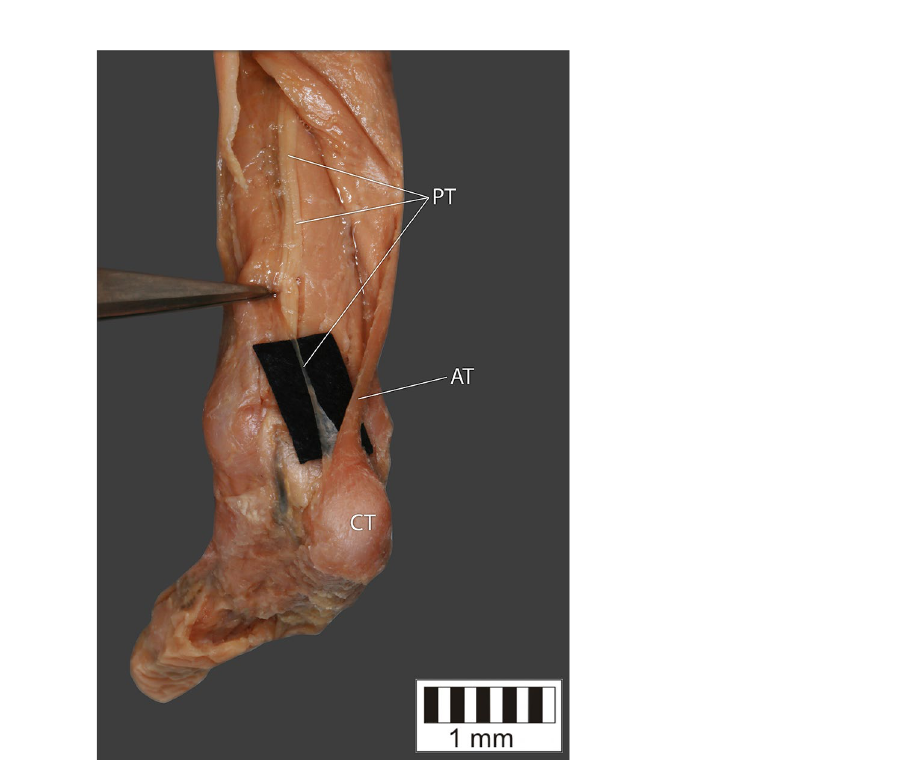
Figure 6. Type IV of plantaris tendon. CT calcaneal tuberostity, AT Achilles tendon, PT plantaris